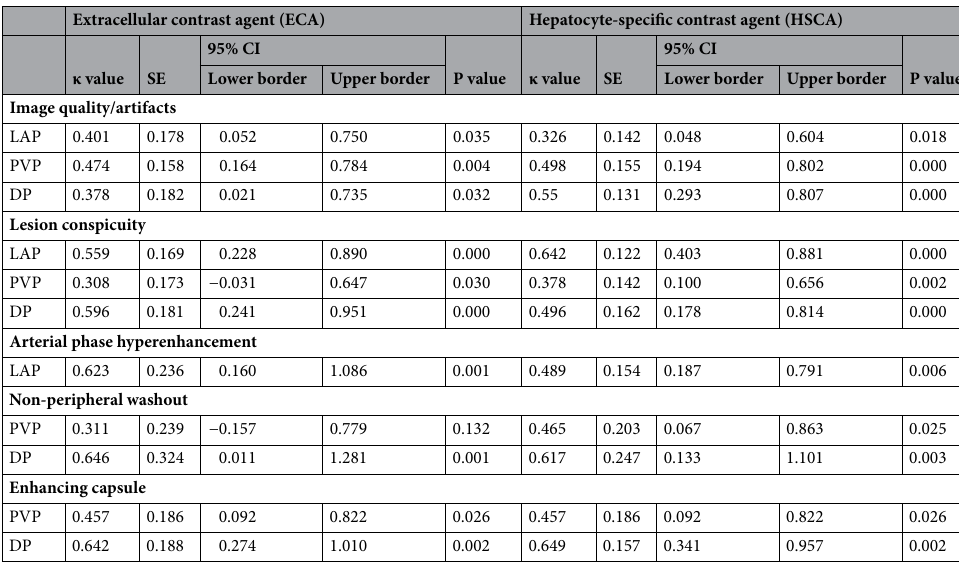
Table 4. Inter-observer agreement for different qualitative parameters including analysis of overall image quality, artifacts, and lesion conspicuity as well as major imaging features of LI-RADS v2018 including arterial phase hyperenhancement, non-peripheral wash-out and enhancing capsule for both contrast agents and throughout the different perfusion phases. LAP late arterial phase, PVP portal venous phase, DP delayed